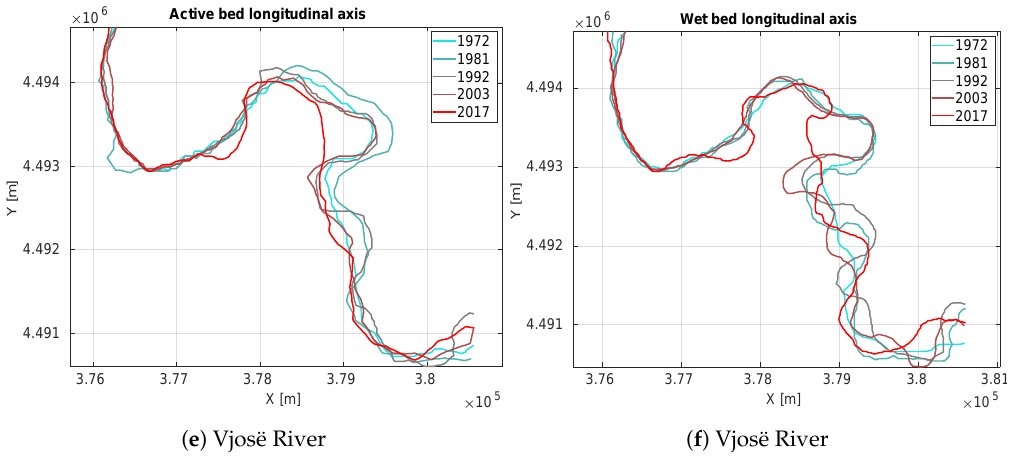
Figure 6. Multi-temporal evolution of the active channel centerline ( Left ) and of the wet channel centerline ( Right ) for the Shkumbin ( a , b ), Seman ( c , d ) and Vjosë ( e , f ) rivers.